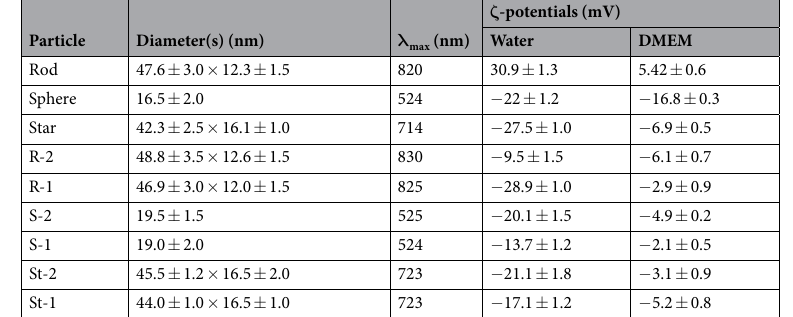
Table 1. Physical characteristics of AuNPs.